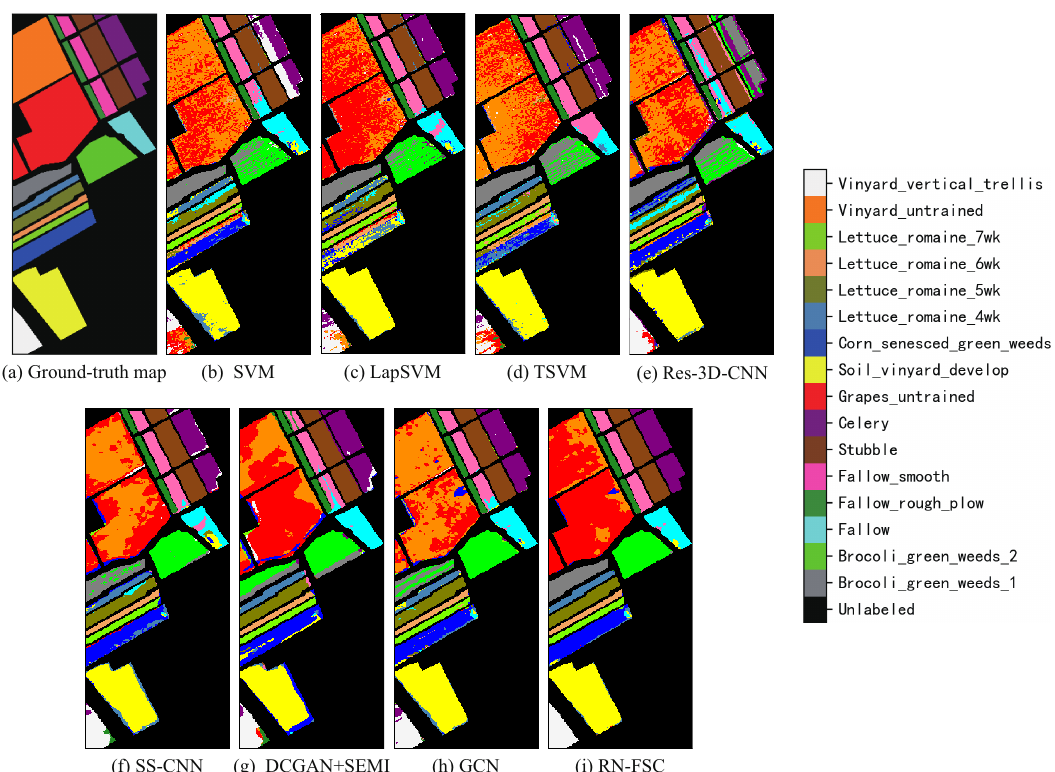
Figure 14. Classification maps resulting from different methods on the SA data